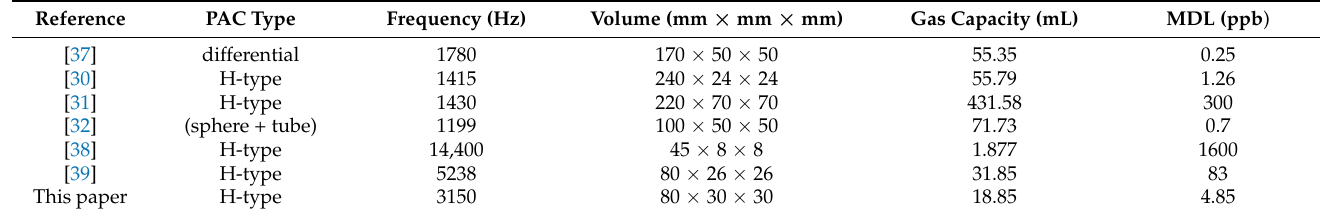
Table 1. Comparison of the developed sensor and previously reported